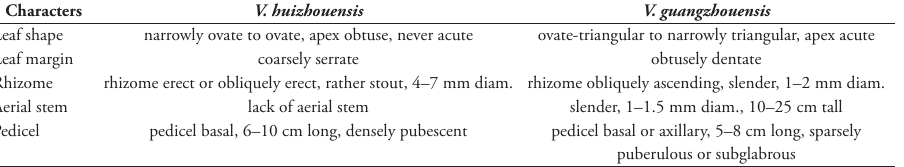
Table 1. Morphological differences between the species V. huizhouensis and V. guangzhouensis .